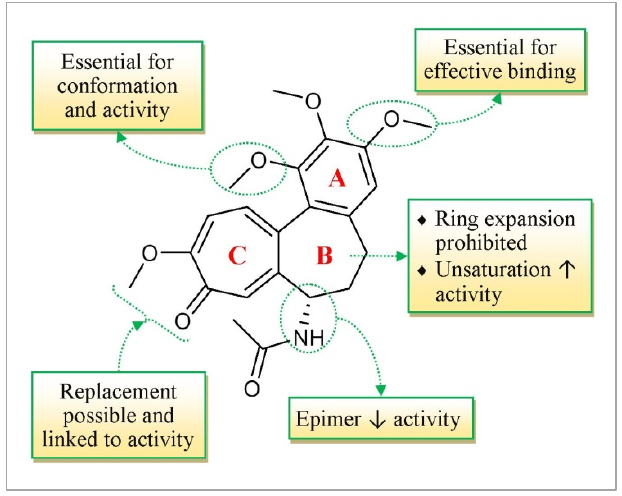
Figure 8. SAR of colchicine; ↑ and ↓ indicate increase and decrease